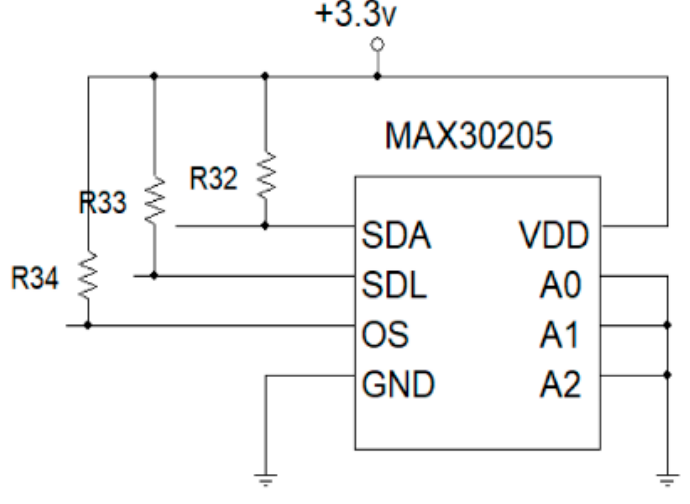
Figure 2. Temperature-sensor wiring diagram.